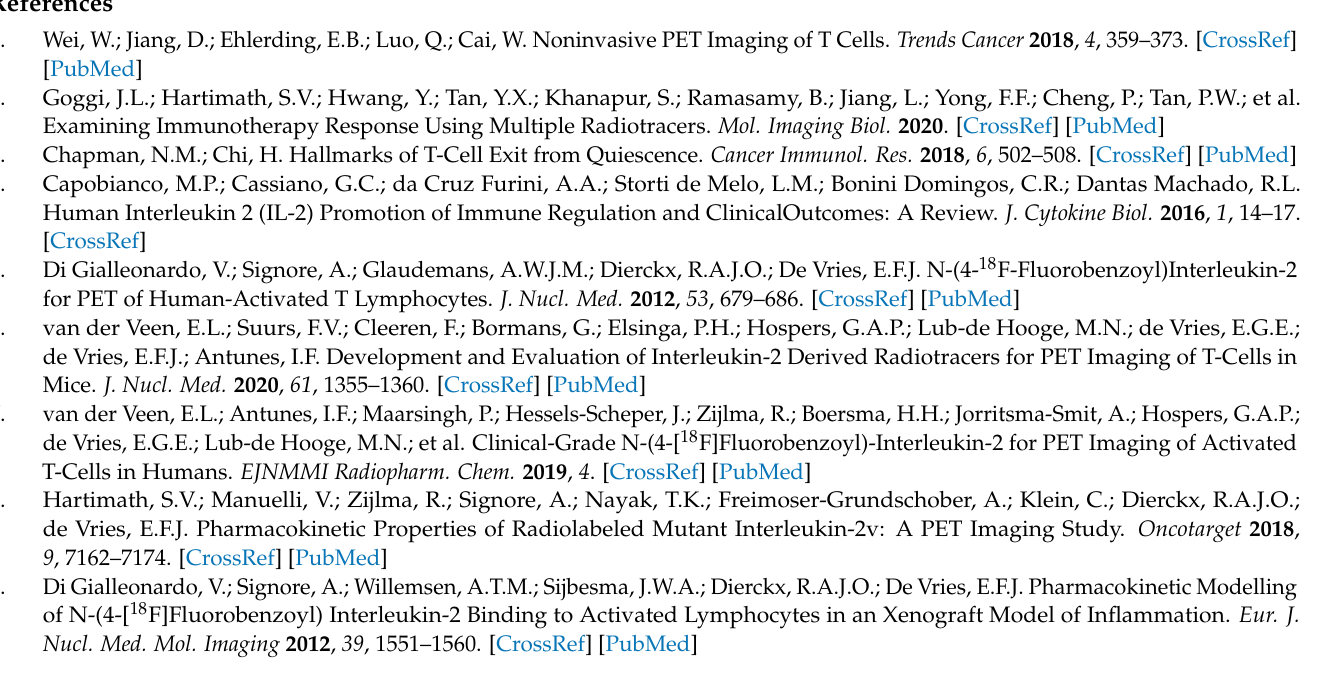
Supplementary Materials: Figure S1: Schematic diagram of Scintomics sequence visualization file of semi-automated [ 18 F]SFB synthesis with positions of reagent vials, reaction vial, transfer lines and a syringe, Table S1. Scintomics GRP™ time control file (sequence) for semi-automated [ 18 F]SFB, Table S2. Gradient elution profile for [ 18 F]SFB analysis by RP-HPLC, Figure S2. Radio- and UV chromatograms of the DMSO reconstituted radiosynthon, [ 18 F]SFB, Figure S3. Calibration curve of N -succinimidyl 4-fluorobenzoate, SFB, Table S3. Calibration curve calculations of N-succinimidyl 4- fluorobenzoate, SFB, Table S4. Gradient elution for [ 18 F]FB-IL-2 analysis by RP-HPLC, Figure S4. Cal- ibration curve of N -(4-fluorobenzoyl)-interleukin-2, FB-IL2, Table S5. Calibration curve calculations of N -(4-Fluorobenzoyl)-Interleukin-2,